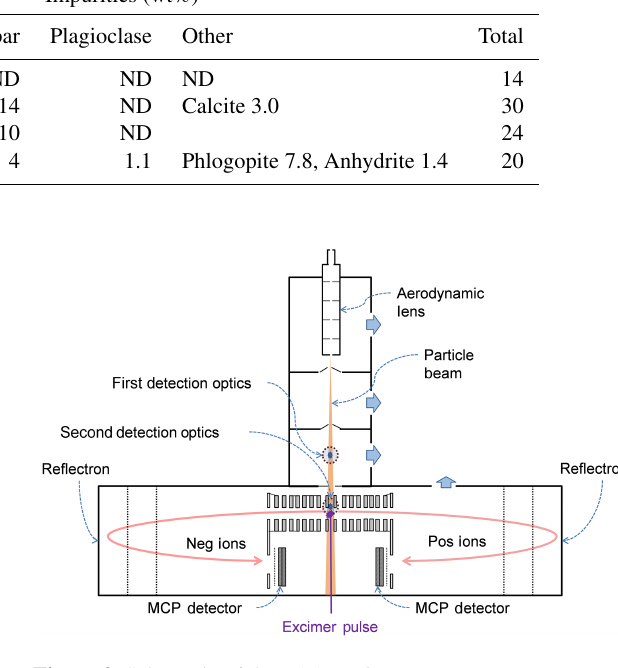
Figure 2. Schematic of the